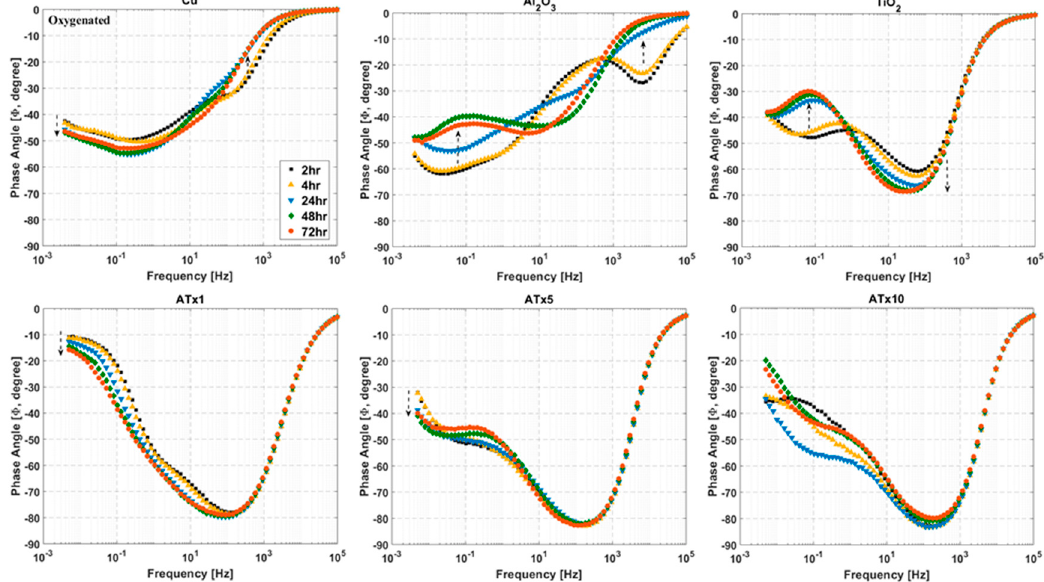
Figure 10. Impedance phase angle versus frequency at selected immersion times over 72-h immersion in oxygenated 0.1 M NaCl. Frequency range is 100 kHz to 5 mHz and sample type is given above each plot. Dashed arrows indicate increasing immersion time. Refer to Table 1 for sample descriptions.